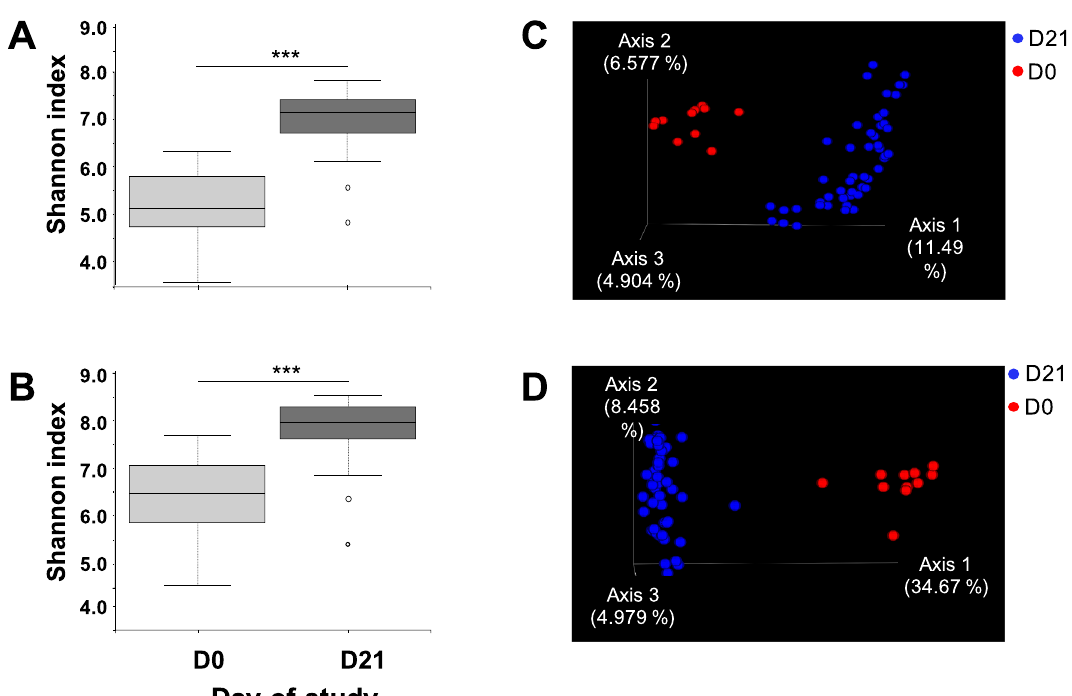
Figure 2. Alpha and beta diversity of faecal and nasal microbiota change through time. Alpha diversity estimated using Shannon’s index on rarefied samples from fecal content ( A ) or nasal swabs ( B ) compared before starting the treatment with feed addtives (D0) and after 21 days of treatment (D21). The dotted lines represent standard deviation and outliers are indicated with white circles. Beta diversity analysis on Bray Curtis’